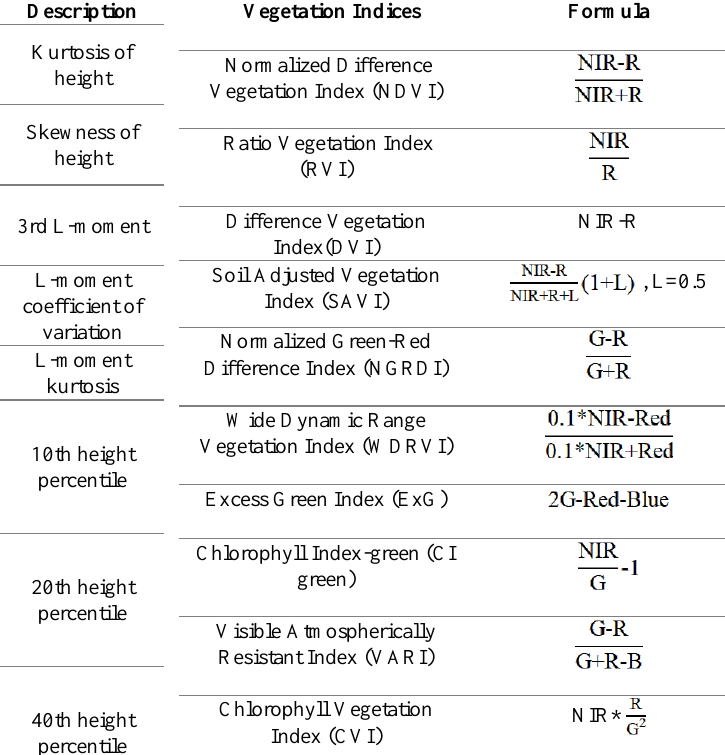
Table 2 . Vegetation indices derived from Landsat 5 TM imagery for AGB estimation over Huntington Wildlife